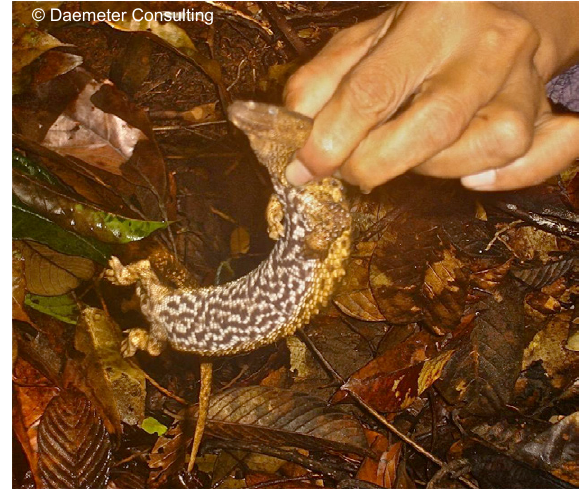
( belukar ) of various ages/stages of regrowth